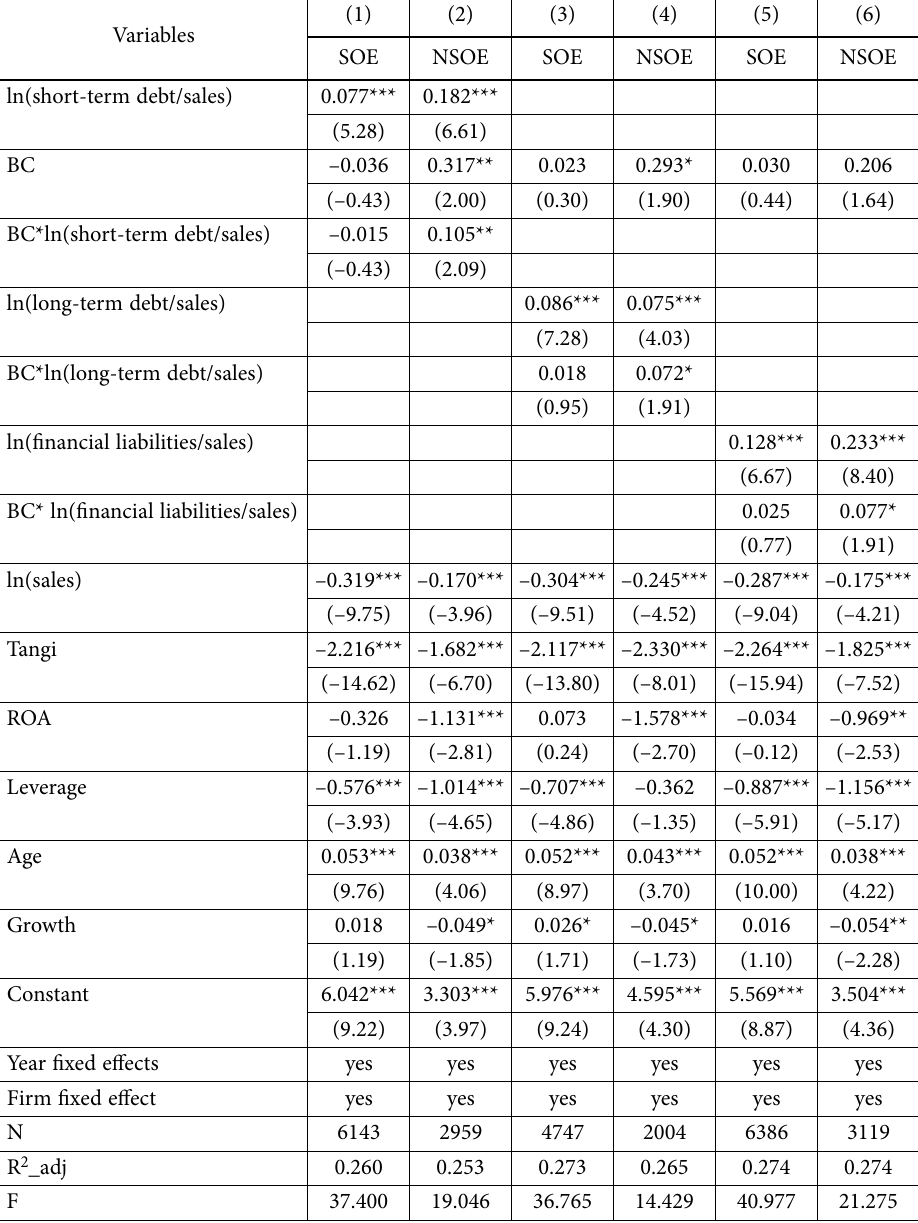
Table 5. Bank connections and firms’ shadow banking behaviour by ownership type